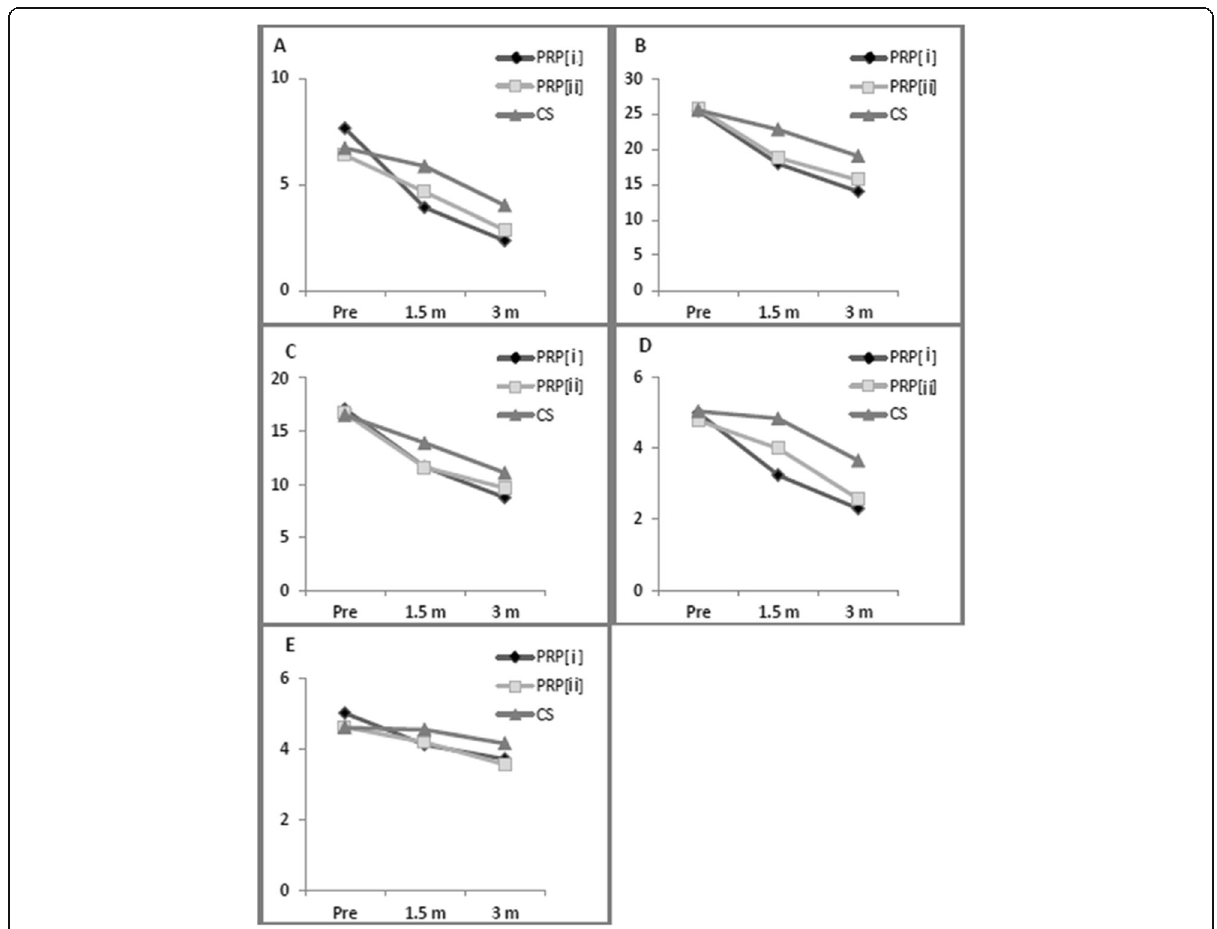
Fig. 1 Mean changes in outcome variables at pre-injection and 1.5 and 3 months follow-up. a VAS, visual analog scale; b BCTQs, Boston Carpal Tunnel Syndrome Questionnaire severity; c BCTQf, Boston Carpal Tunnel Syndrome Questionnaire function; d DML, distal motor latency; and e SPL, sensory peak latency. On comparing the pre-injection status, PRP [i] and PRP [ii] groups showed significant improvement in all outcome variables detected at 1.5 and 3 months of follow-up. In the CS group, a significant improvement only in BCTQf was detected at 1.5 months of follow up compared to the pre-injection status ( P = 0.02). PRP, platelet rich plasma; CS,